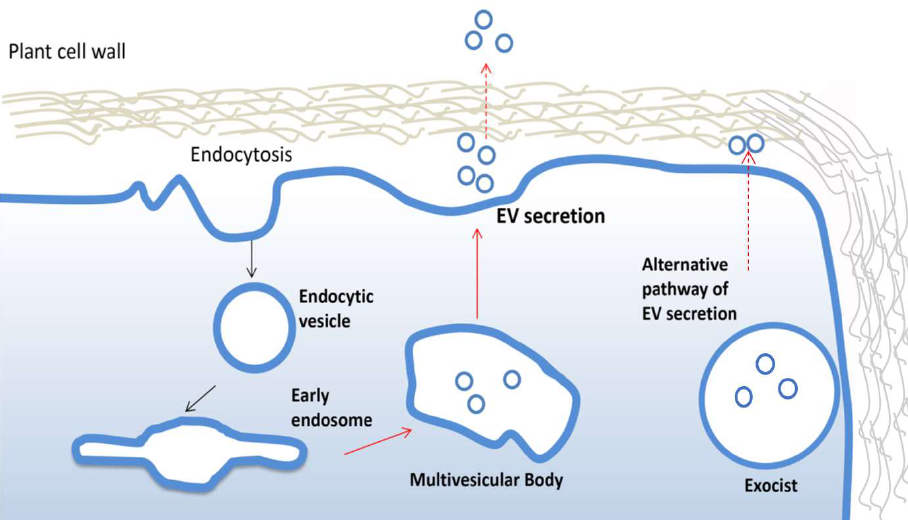
Figure 2. Biogenesis and secretion of plant extracellular vesicles. Plant extracellular vesicles (EVs) derive from early endosomes originated from plasma membrane by endocytosis. An early endosome becomes late endosomes and then forms multivesicular bodies which fuse with the membrane to release EVs. The alternative exocyst-mediated EVs secretion pathway described in plant is also shown.